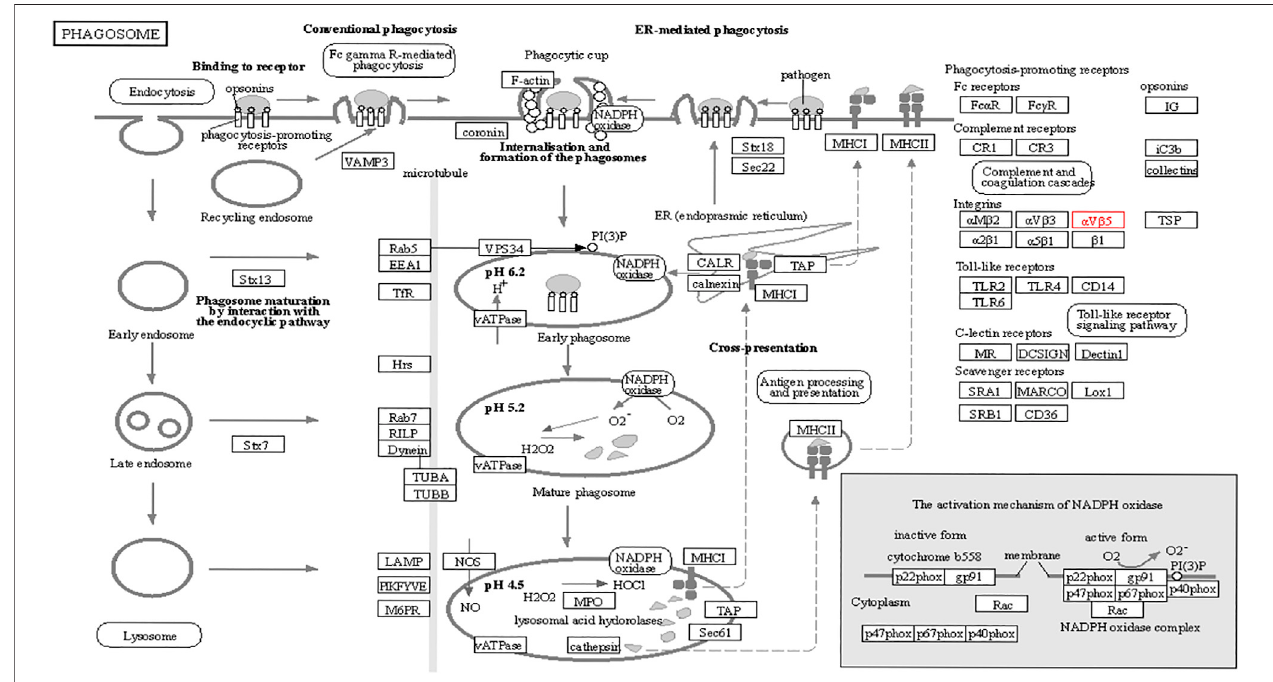
FIGURE 14 | Phagosome pathway regulated by